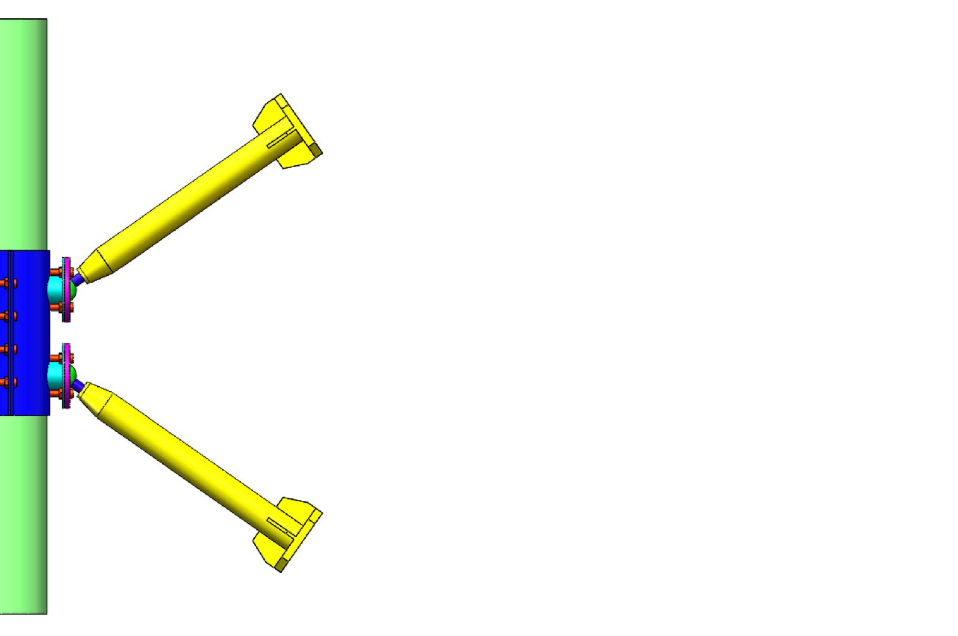
Figure 12. Joint assembly diagram (SolidWorks 2020 https:// www. 3ds. com/ produ cts- servi ces/ simul